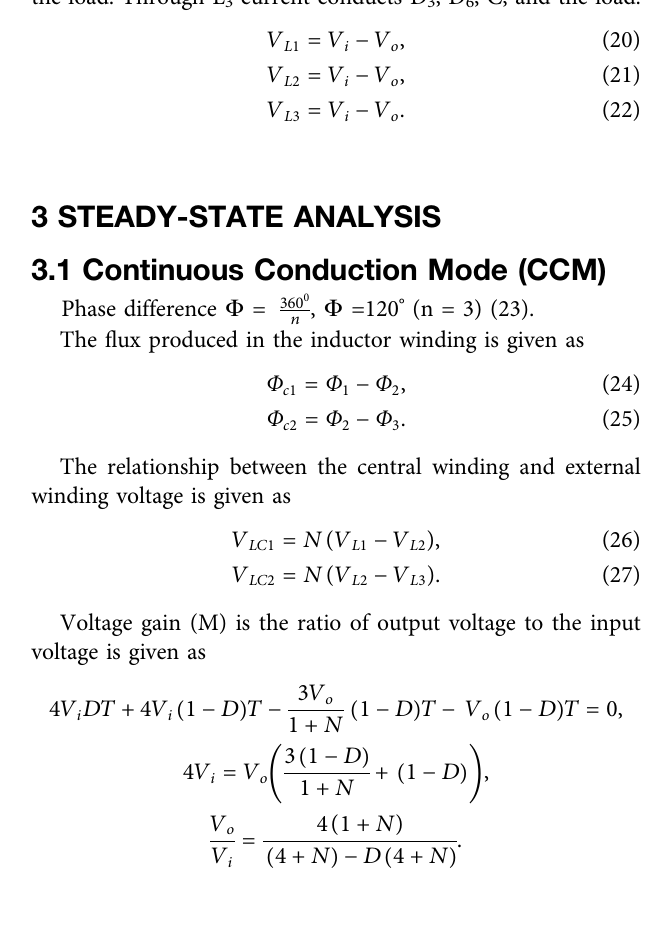
Mode 2: as Figure 3B depicts, initially the switch S S 1 and S 3 are in an OFF condition. Current from the battery fl ows to the switch S 2 through the winding L 2 . The battery current also conducts L 1 and L 3 . Current fl ows through L 1 to D 1 , L C1 , D 5 , C, and the load. Current fl ows through L 3 to D 3 , L C2 , D 5 , C, and the load.